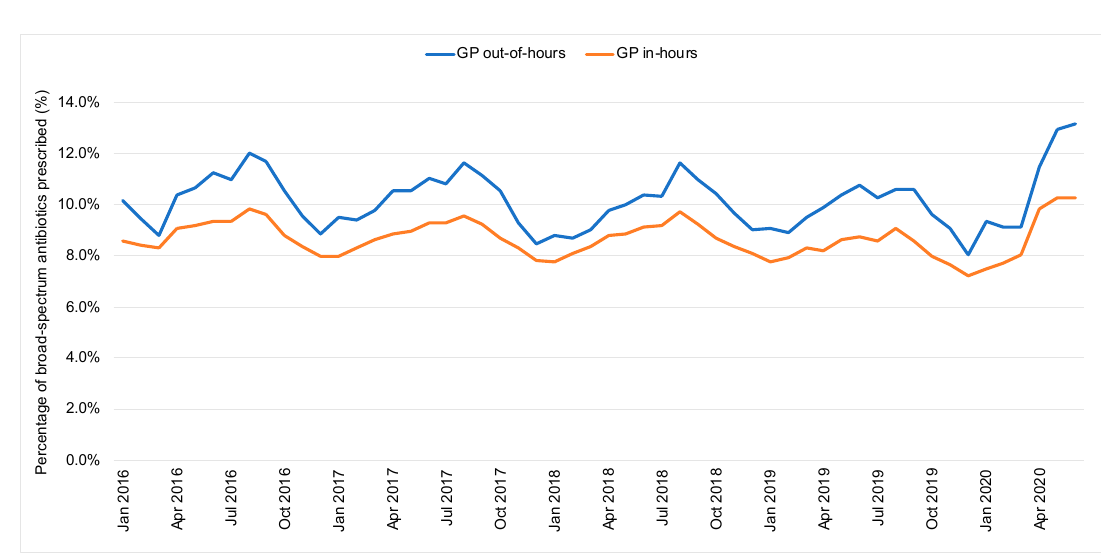
Figure 1. Total number of antibiotic items prescribed (England, 2016–2020). The proportion of broad-spectrum antibiotics to total antibiotic prescribing in OOH was consistently higher (10.1%, 95% CI: 10.0% to 10.2%, P < 0.05) compared with in-hours (8.7%, 95% CI: 8.6% to 8.8%, P < 0.05) (Figure 2). Before March 2020, the proportion of prescribed broad-spectrum antibiotics decreasing by 0.02% per month in GP IH settings (95% CI: − 0.03% to − 0.01%, p < 0.05). While a decrease of 0.02% per month was observed in the proportion of prescribed broad-spectrum antibiotics in OOH, this is insignificant ( p = 0.06).